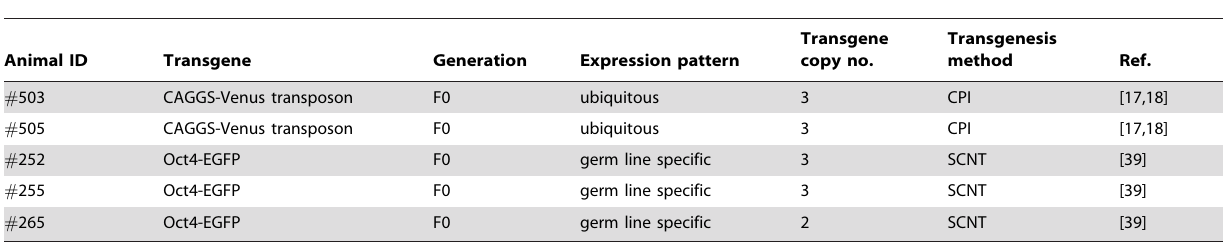
Table 1. Transgenic boars used for spermatozoa analysis.